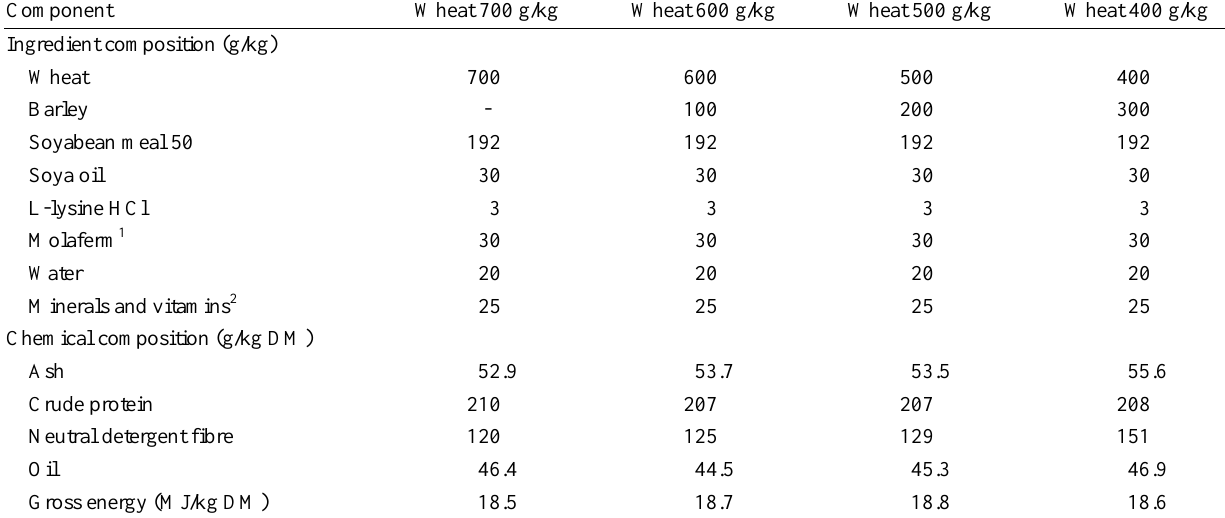
Table 1. Ingredient and chemical composition of experimental diets